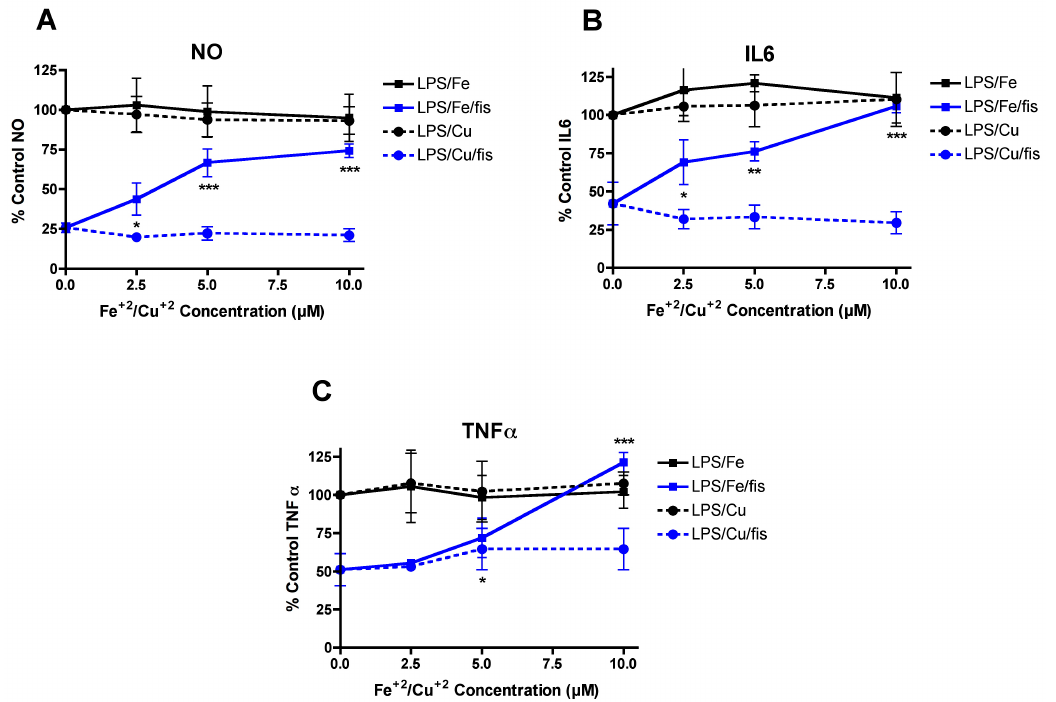
Figure 5. FeCl 2 and CuCl 2 differentially modulate the anti-inflammatory effects of fisetin. Dose dependent effects of FeCl 2 and CuCl 2 on the inhibition of NO and pro-inflammatory cytokine production by fisetin in LPS-treated BV-2 microglial cells. BV-2 cells were treated overnight with 25 ng/mL LPS in the presence of 5 µM fisetin alone or with the addition of the indicated concentrations of FeCl 2 or CuCl 2 . Cell culture supernatants were cleared and assayed for NO by the Griess assay or pro-inflammatory cytokines using specific ELISAs. Results are presented as the percent (%) of the value obtained with LPS alone which was set at 100%. ( A ) NO, ( B ) IL6, ( C ) TNF α . The results represent the average of 3–4 independent experiments. * indicates p < 0.05, ** indicates p < 0.01 and *** indicates p < 0.001 relative to fisetin + LPS alone.